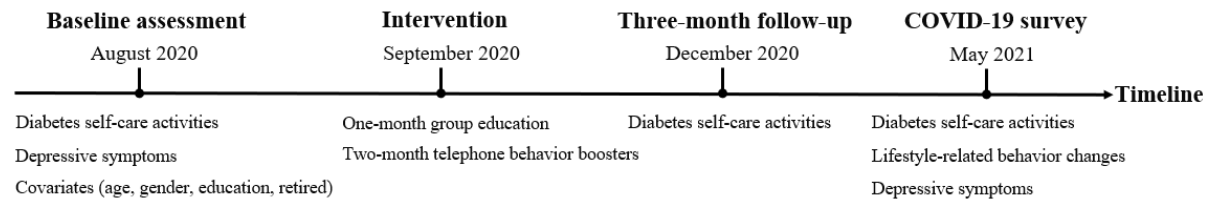
Figure 2. Measures across study